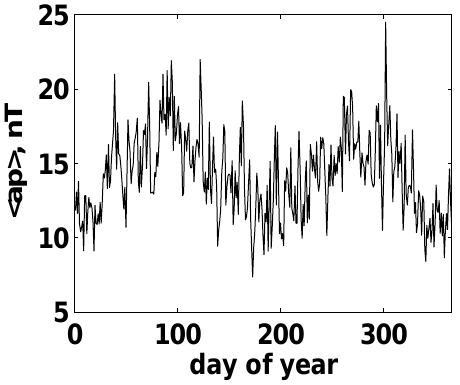
Fig. 1. Seasonal periodicity in daily a p index averages.